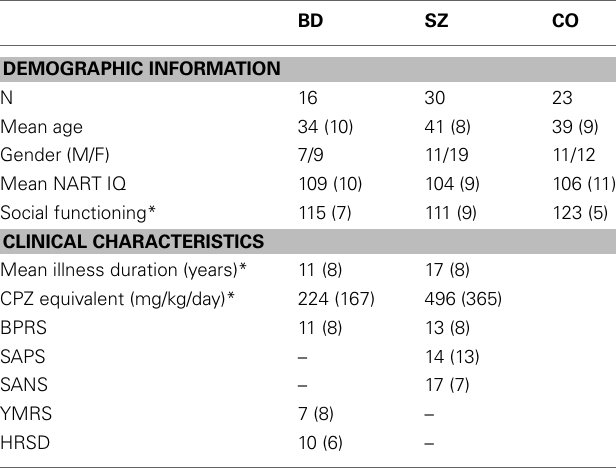
Table 1 | Demographic and clinical information on subject